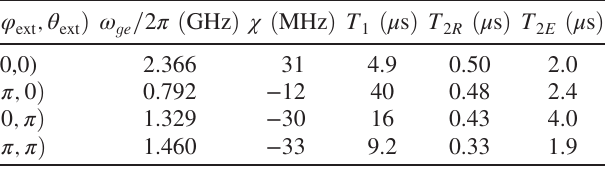
TABLE II. Coherence properties at the four distinct two- dimensional external flux sweet spots for the first excited state transition. Here, χ denotes the dispersive shift on the readout resonator, T 1 denotes the relaxation time, T 2 Ramsey decoherence time, and T 2 decoherence